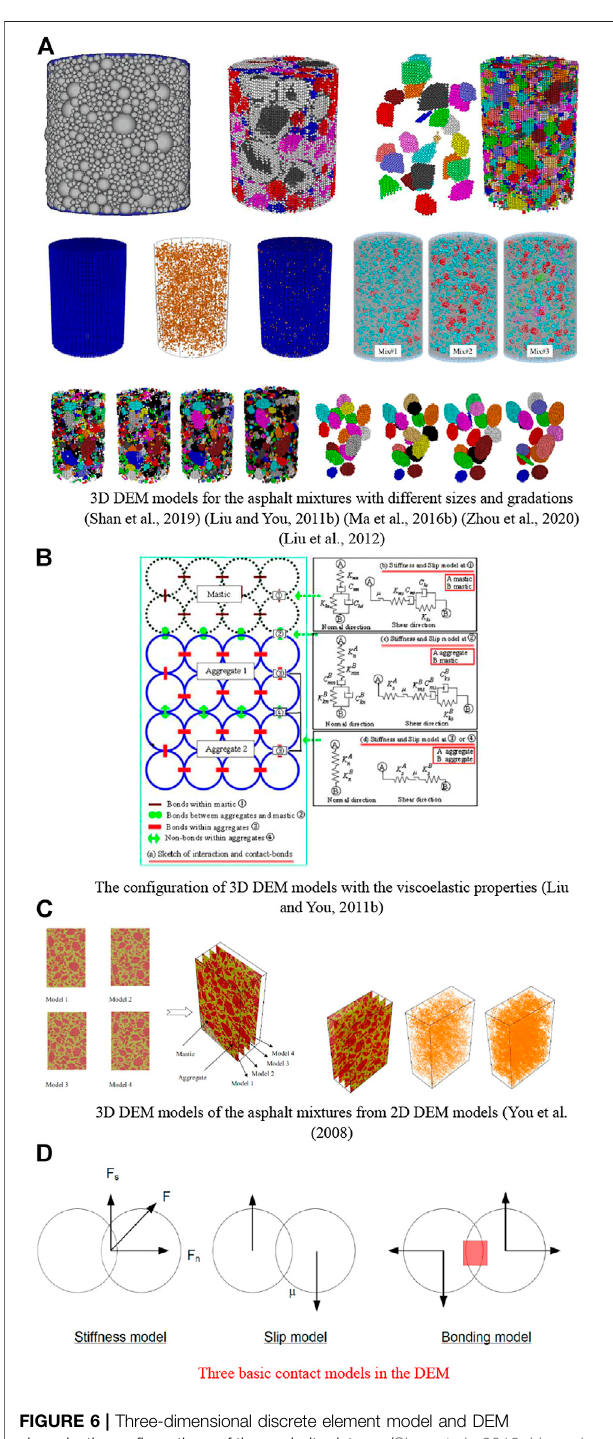
FIGURE 6 | Three-dimensional discrete element model and DEM viscoelastic con fi gurations of the asphalt mixtures (Shan et al., 2019; Liu and You, 2011b; Ma et al., 2016b; Zhou et al., 2020; You et al., 2008; Liu et al., 2012). (A) 3D DEM models for the asphalt mixtures with different sizes andgradations(Shanetal.,2019;LiuandYou,2011b;Maetal.,2016b;Zhou etal.,2020;Youetal.,2008;Liuetal.,2012). (B) Thecon fi gurationof3DDEM models with the viscoelastic properties (Liu and You, 2011b). (C) 3D DEM models of the asphalt mixtures from 2D DEM models(You et al., 2008). (D) Three basic contact models in the